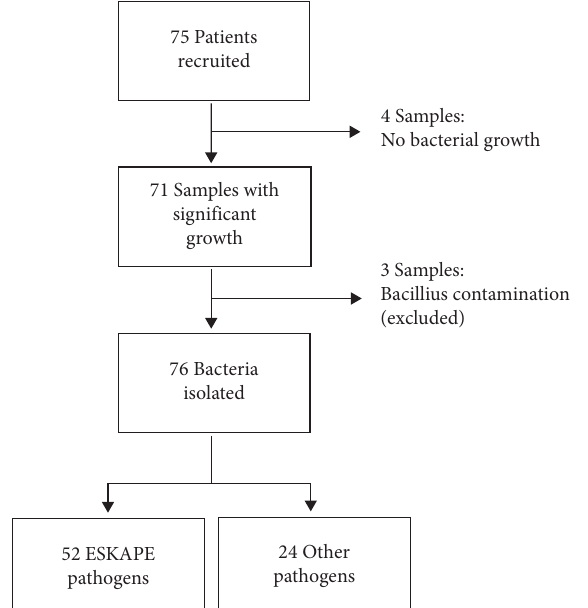
Figure 1: Categorization of bacteria isolates. Te fgure shows a schematic diagram of the overview samples eliminated and diferentiation of pathogens isolated from pus swabs of admitted